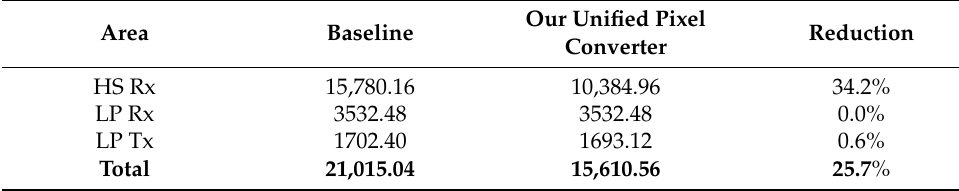
Table 2. Area comparison (um 2 ).